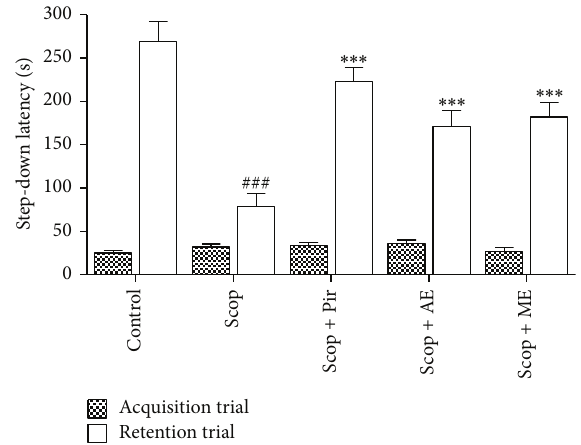
Figure 6: The effect of AE and ME seed extracts of Abelmoschus esculentus on scopolamine-induced learning and memory impair- ment in the passive avoidance test. Control indicates saline-treated group. Scop indicates scopolamine-treated group (0.4 mg/kg, i.p.). Scop + Pir, Scop + AE, and Scop + ME indicate piracetam (Pir), aqueous (AE), and methanolic (ME) seed extracts of A. esculentus (200 mg/kg, p.o.), respectively, treated groups for 7 days once daily. Values are mean latency ± S.E.M ( 𝑛 = 6 ). ### 𝑃 < 0.001 when compared to control group and ∗∗∗ 𝑃 < 0.001 when compared to Scop-treated group. Acquisition-retention trials: F (1, 50) = 351.92, 𝑃 < 0.0001 ; treatments: F (4, 50) = 14.04, 𝑃 < 0.0001 ; interaction (acquisition-retention trials × treatments): F (5, 50 = 15.68, 𝑃 < 0.0001